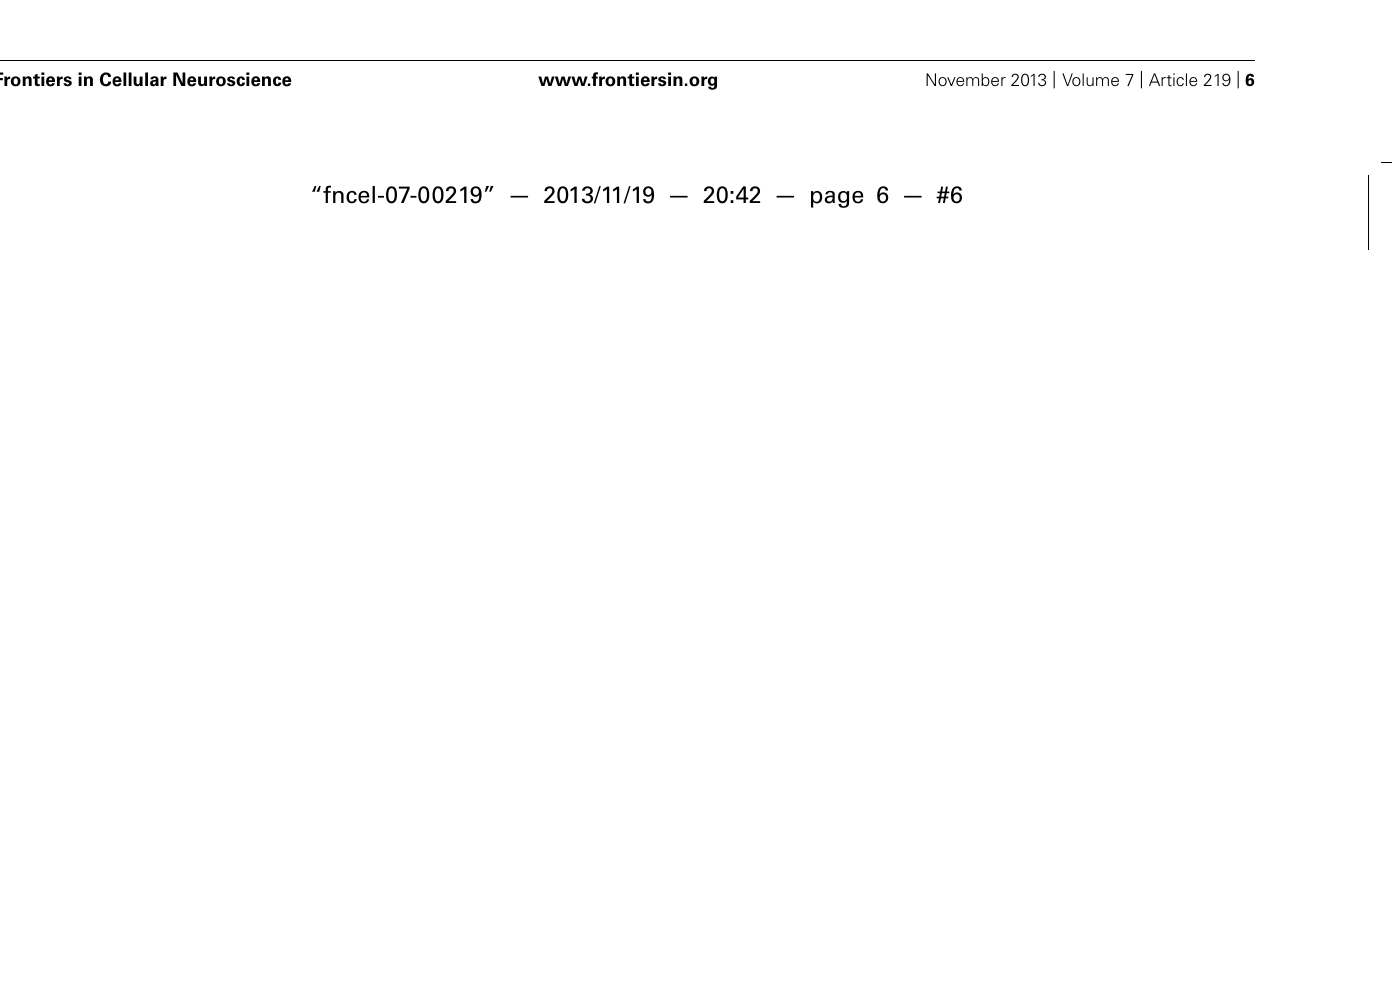
FIGURE 2 | Extrinsic factors: possible activity-dependent changes in cell adhesion molecules. Neural activity may induce a number of changes in adhesion molecules. (A) The expression level of cell adhesion molecules (Cingolani etal., 2008), or their splice variants (Chih etal., 2006; Graf etal., 2006), can be regulated in an activity-dependent manner, potentially affecting synapse formation, and synapse specificity. (B) Activity-dependent redistri- bution of adhesion molecules over the axonal membrane can facilitate